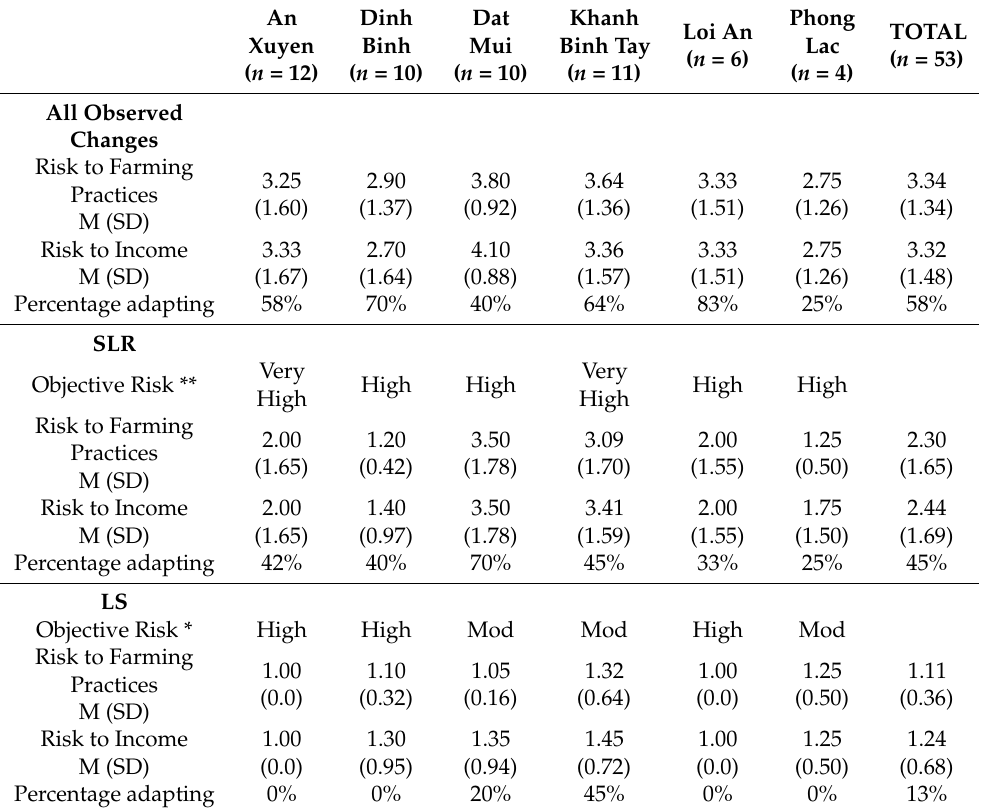
Table 6. Risk perception and